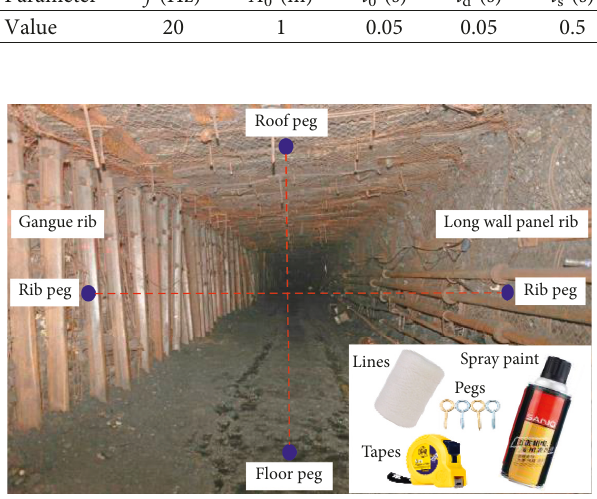
Figure 11: Schematic of the measurement of entry convergence.